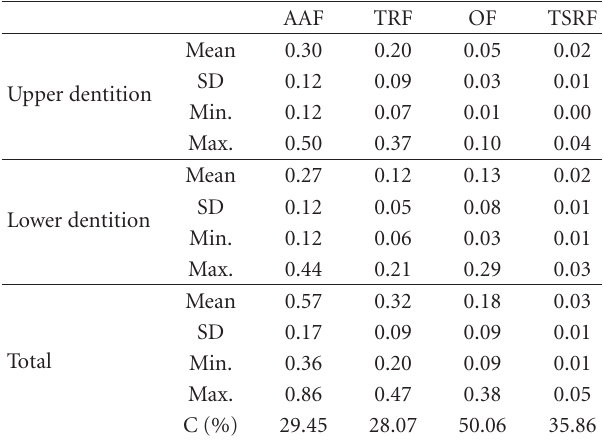
Figure 1: Changes over time in fluoride concentration in saliva following 2% neutral NaF foam application. A–H indicates each subject in this Table 2: The appropriate amounts of foam (AAF), tray-retained foam (TRF), overflowed foam (OF) and tooth-surface-retained (TSRF) on the permanent dentition study model. AAF TRF OF TSRF Mean 0.60 0.43 0.07 0.08 SD 0.20 Upper dentition 0.14 Mean 0.35 0.18 0.11 0.04 SD 0.16 0.06 0.02 Lower dentition Min. 0.22 0.01 Max. 0.75 0.32 0.38 0.06 Mean 0.96 0.60 0.17 0.12 SD 0.24 0.06 Total Min.